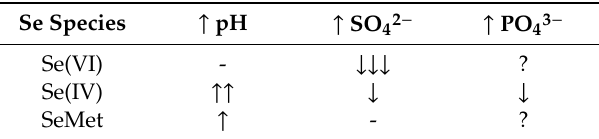
Table 1. Overall e ff ect of an increase ( ↑ ) in pH, sulfate (SO 42 − ), or phosphate (PO 43 − ) on the uptake of selenate (Se(VI), selenite (Se(IV)), or selenomethionine (SeMet); ↑ = increase in uptake; ↓ = decrease in uptake; - = no e ff ect; ? = contradictory or no observations. Se Species ↑ pH ↑ SO 42 − ↑ PO 43 − Se(VI) - ↓↓↓ ? Se(IV) ↑↑ ↓ ↓ SeMet ↑ -